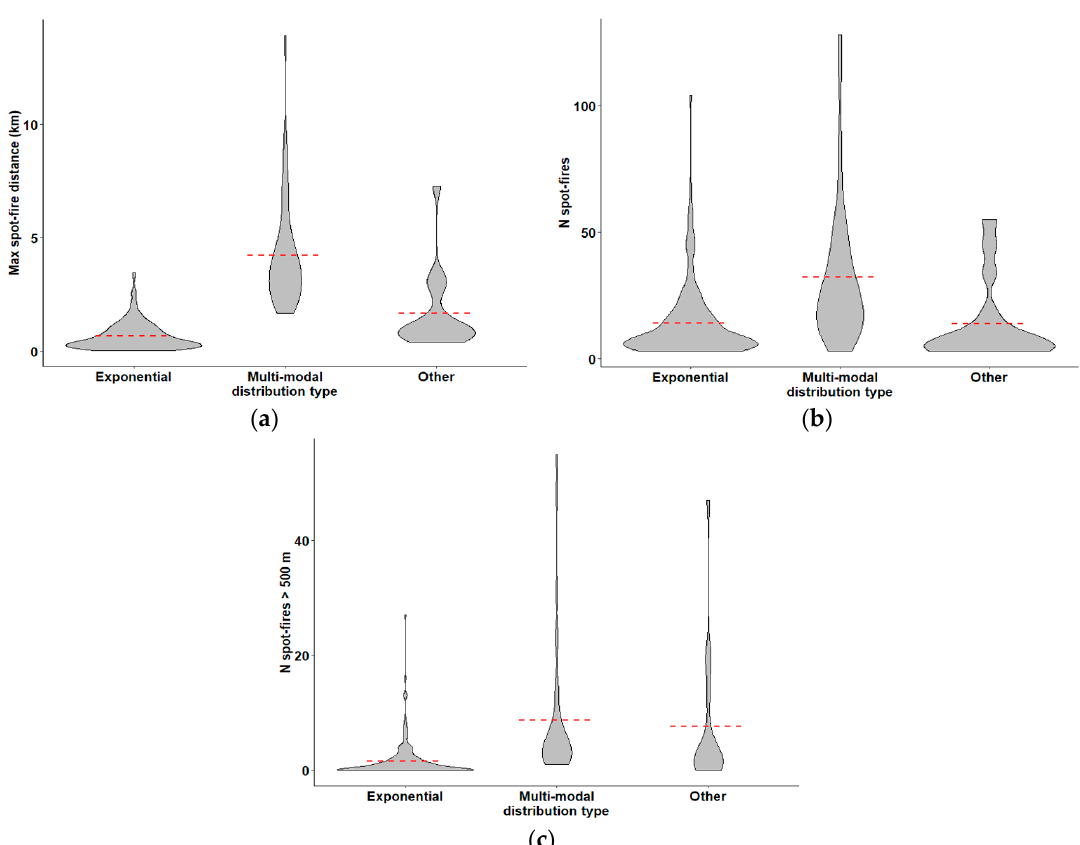
Figure 8. Violin plots of distribution type vs. maximum spot fire distance ( a ), number of spot fires ( b ),